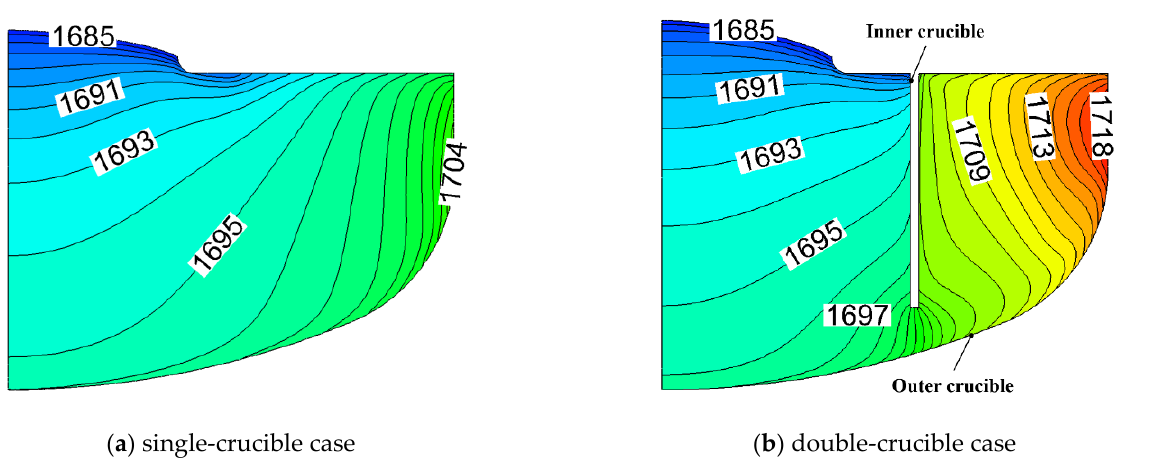
Figure 2. Temperature distributions (K) in the melt: ( a ) the case with the conventional single-crucible method, ( b ) the case with the double-crucible